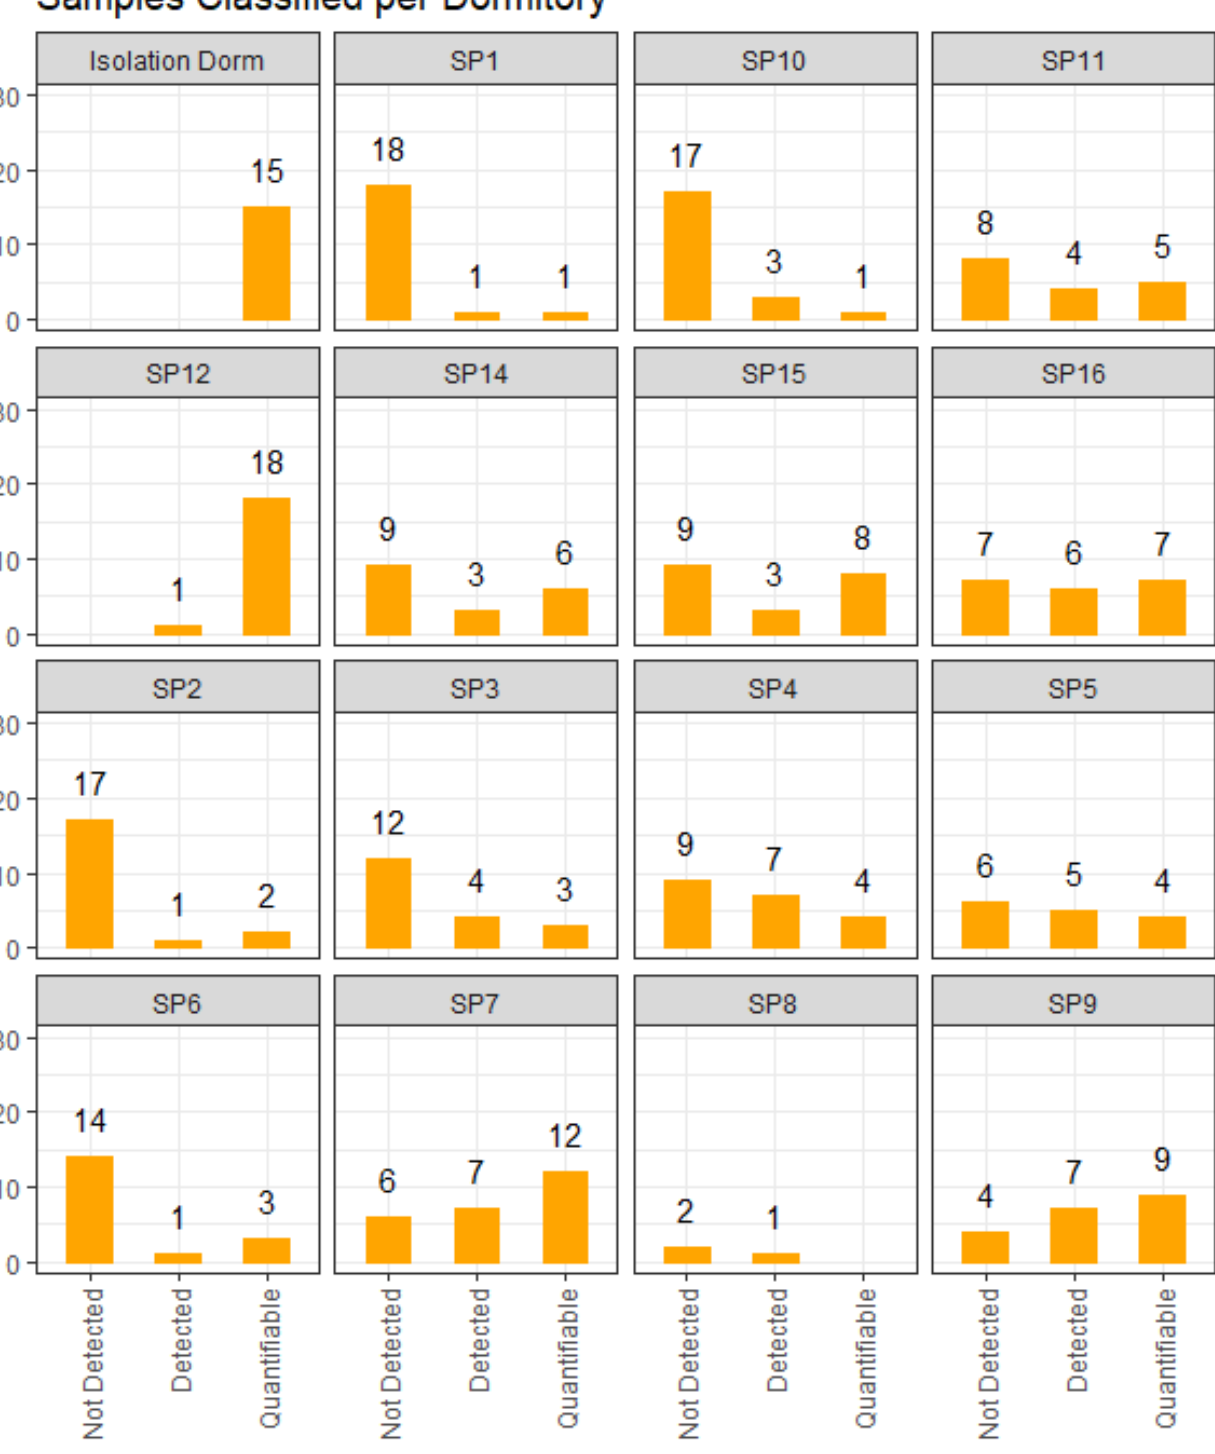
Figure 4. Samples classified by dormitory.